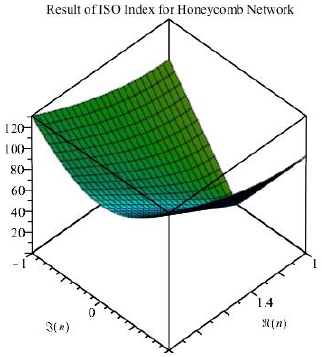
Figure 8. Result of ISO index for honeycomb network.